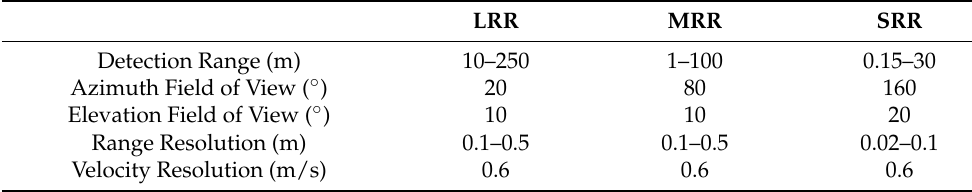
Table 1. Comparison of different automotive mm-wave radars [50].